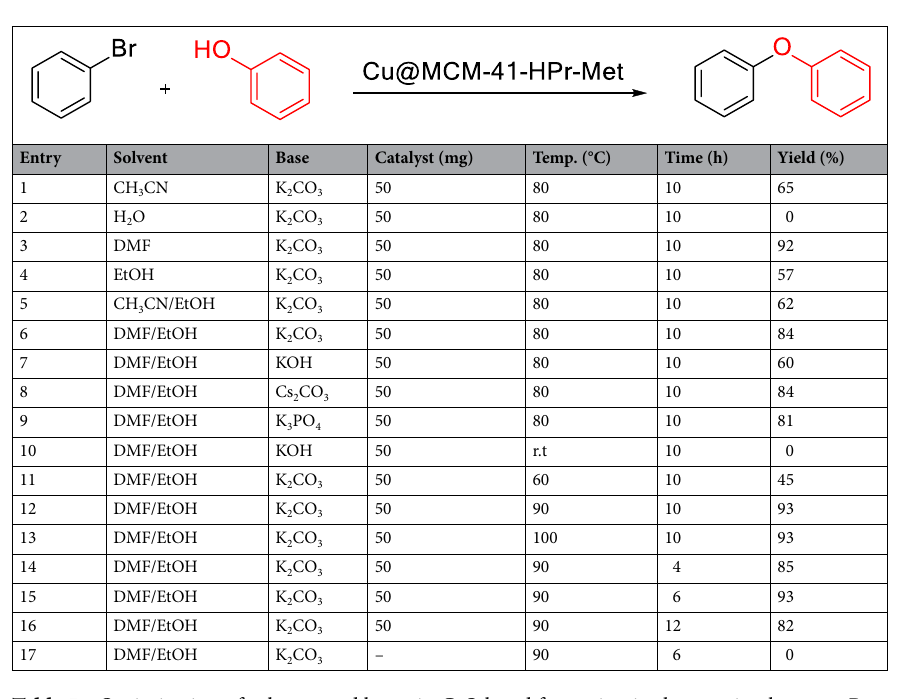
Table 5. Optimization of solvents and bases in C-O bond formation in the reaction between Bromobenzene and phenol as a model